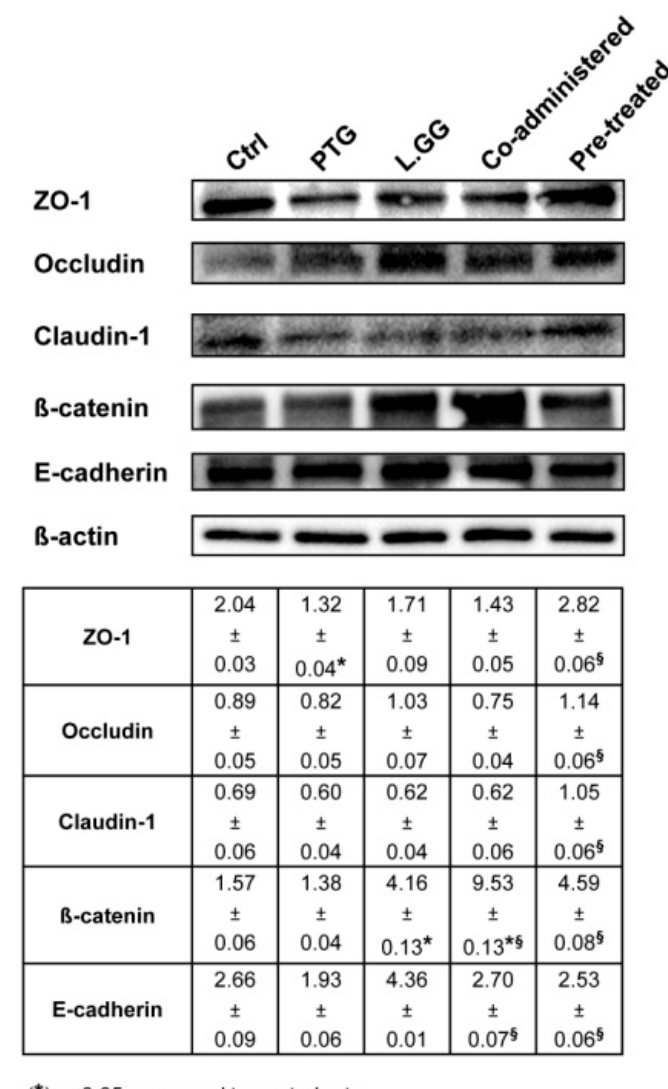
Figure 5. Western Blot Analysis of ZO-1, Occludin, Claudin-1, β -catenin and E-cadherin in jejunal tissue samples from control and treated rats. Ctrl (without treatment); PTG (sensitized with 1000 U IFN- γ and treated with PTG 50 µg/day for ten days); L.GG (treated with L.GG 1 × 10 9 CFU for ten